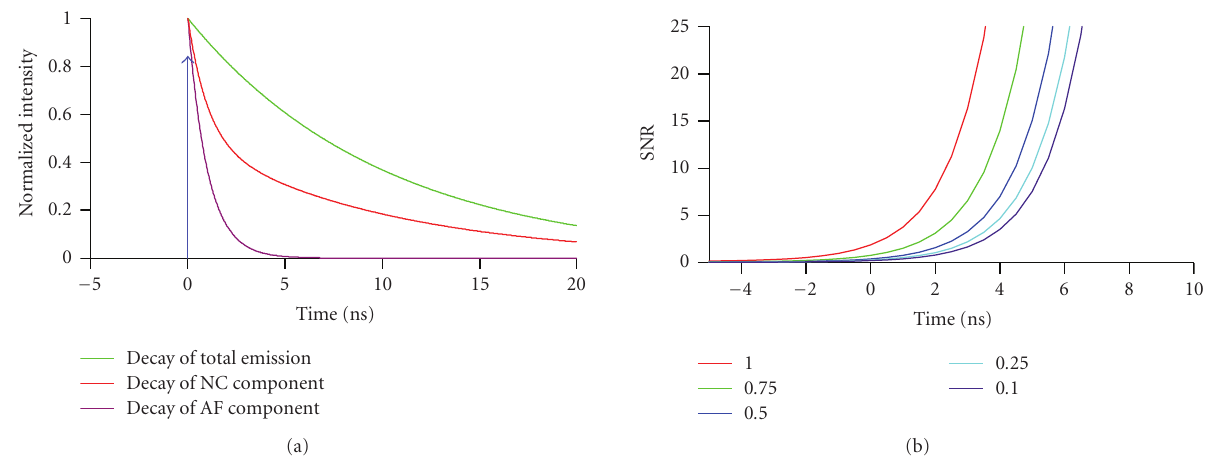
Figure 1: Time-gated acquisition of nanocrystal photoluminescence suppresses short-lived autofluorescence, [6]. (a) Schematic representa- tion of the relative timing of the laser pulse (instantaneous, blue), along with the normalized decays of autofluorescence (AF, purple, τ = 1 nanosecond), NC photoluminescence (NC, green, τ = 10 nanoseconds), and their sum (red), respectively. (b) Background rejection versus gate time. SNR is the ratio of the integrated signal of the NC divided by the integrated signal of the AF. The numbers/colors represent 5 di ff erent ratios I NC /I AF . To obtain the same SNR at a higher level of AF, a larger time gate is required. The shift in time is relative to the center of a sigmoidal function 1/(1 + exp ( − T/t )) that describes detector gating. We assumed a detector on response (10–90%), T = 4.4 nanoseconds. Thus, at Δ t = 0 detection e ffi ciency is 50%.